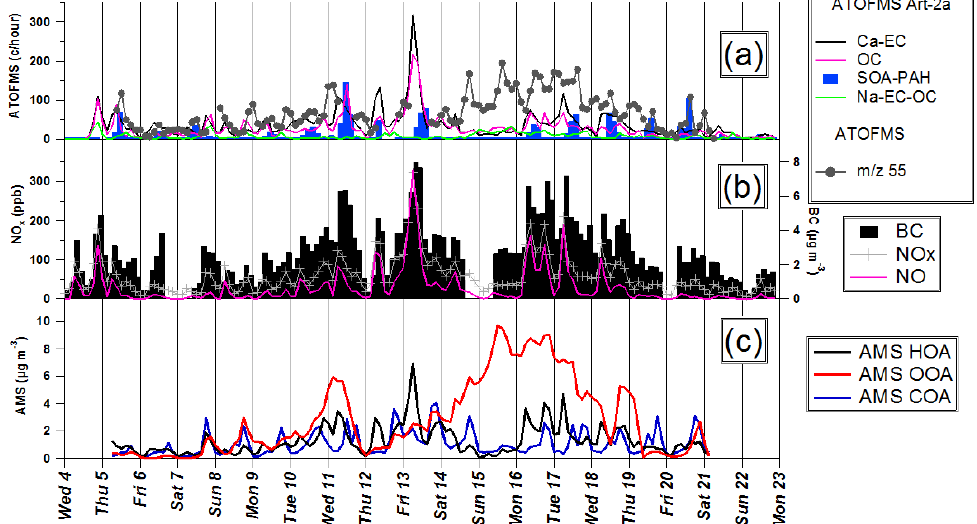
Fig. 4. Temporal trends of (a) ATOFMS clusters described in Fig. 1, (b) BC and nitrogen gases and (c) AMS profiles as reported in Allan et al.